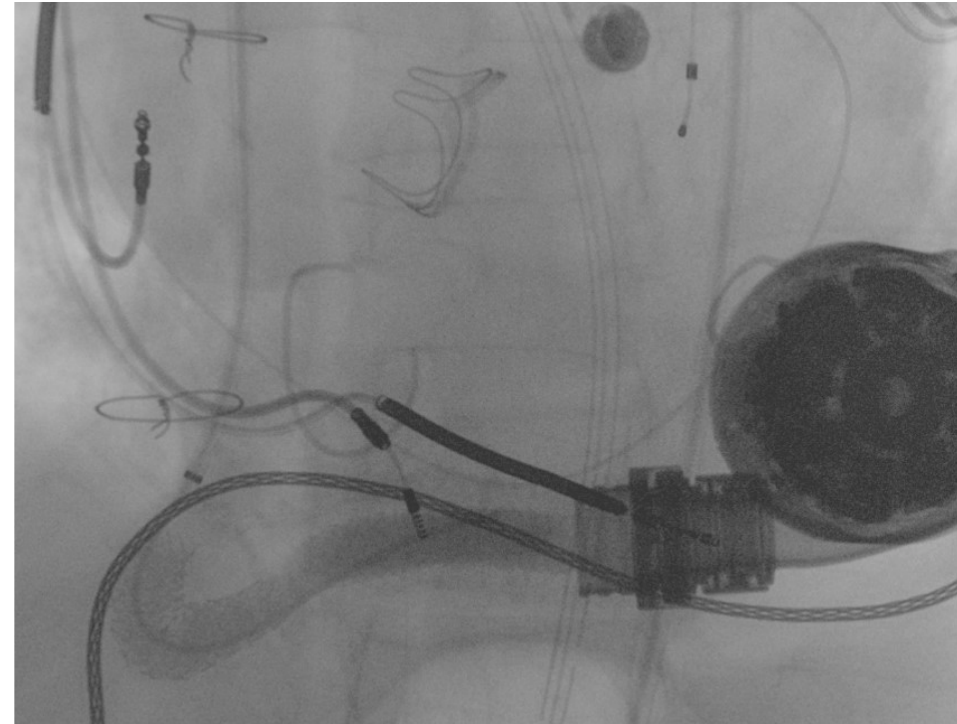
Figure 5. Final result following the percutaneous intervention.